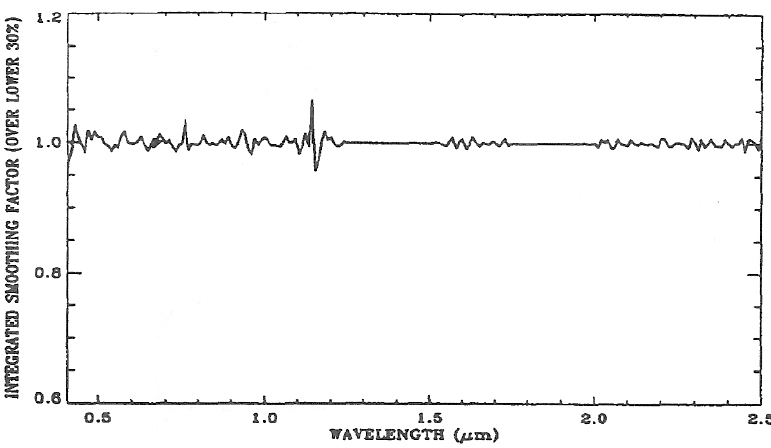
Figure 3. A sample gain